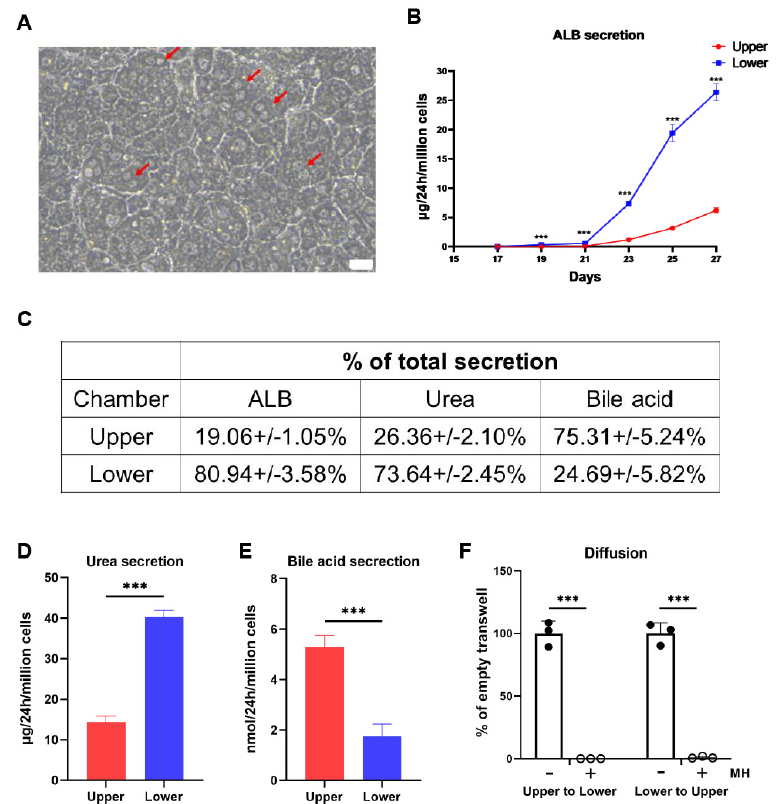
Figure 2. Characterization of the capacity of the directional secretions in the polarized hEHs. ( A ) Morphology of the polarized hEHs at day 27 after the differentiation, red arrows indicated binucleated polarized hEHs, scale bars = 20 μ m. ( B ) Time course of the directional ALB secretion in the polarized hEHs through ELISA analysis. ( C ) Calculation of the secretion ratio of hepatic cargos in the medium between the upper and lower chambers. ( D , E ) Analysis of the directional secretions of urea and bile acids in the medium of the polarized hEHs between the upper and lower chambers at day 27 after the differentiation. ( F ) The determination of the paracellular permeability of the polarized hEHs incubated with 4kDa FITC − dextran by fl uorescence analysis. The symbols “+” and “ − ” represent the presence or the absence of the polarized hEHs, fl uorescence signals of FITC − labeled dextran that were not detected in the opposite chamber of transwells in the presence of the polarized hEHs, whereas either the upper or lower chambers had equal fluorescence signals in the absence of the polarized hEHs, indicating the directional secretions by the polarized hEHs were not caused by the paracellular permeability. Data represent the mean ± SD. *** p < 0.001. It is well documented that the directional secretion of hepatocytes relies on the appearance of cellular apical and basal membranes [22]. The bile salt export pump (BSEP) is a member of the ABC transporters, which is located on the hepatic apical membrane, and it is responsible for the excretion of intracellular bile acids into the bile canaliculus [17]. Thus, we analyzed the differences in expression and distribution of BSEP between the non-polarized and polarized hEHs. The protein level of BSEP was analyzed by